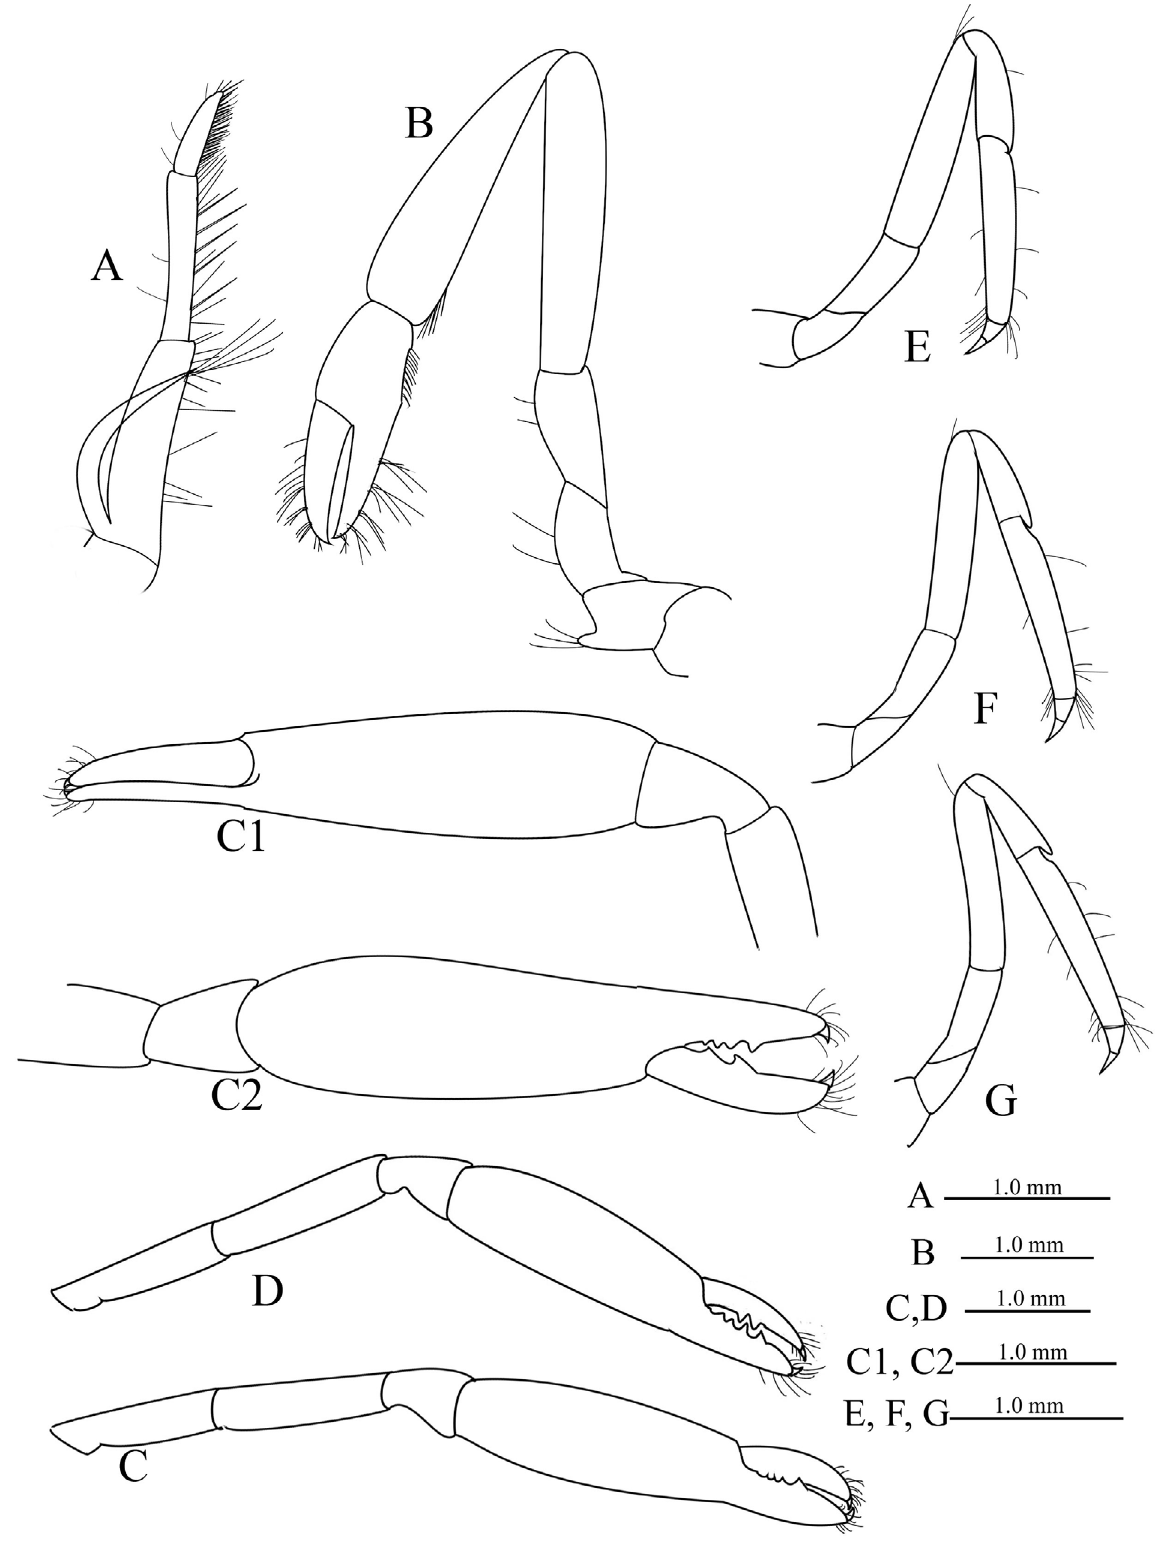
Figure 4. Actinimenes koyas sp. nov. paratype, male, (CL 3.2 mm), NBFGR: DBTLDA62. A , Left third maxilliped (outer view); B , left first pereopod (lateral view); C , major second pereopod (left, lateral view); C1 , lateral view of major chela of the second pereopod; C2 , dorsal view of major chela of same; D , minor second pereopod, right (lateral view); E , left third pereopod (lateral view); F , right fourth pereopod (lateral view); G , right fifth pereopod (lateral